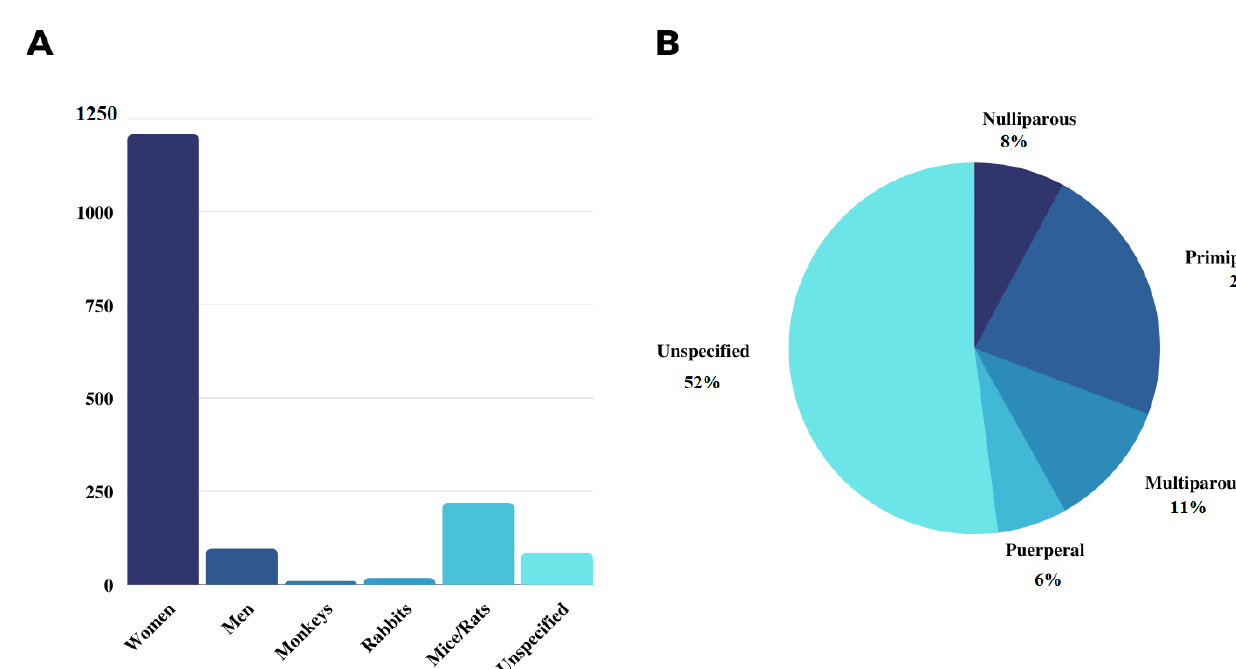
Figure 2. Studied populations ( A ) and female classification ( B ) found in the analyzed studies. Considering the electrical intensity and the intervention site, we found that 16 studies (69.6% of the total reviewed bibliography) treated the studied population with electric intensities varying from 20–50 Hz. Additionally, no differences were observed regarding the electrical intensities applied to humans compared to animals, except for the study by [5], which used the intensity of 1 Hz in Rhesus monkeys, aiming to evoke an answer in the lower urinary tract. Regarding the most approached regions to perform electrical stimulation, 14 studies reported a direct approach to the anogenital region (vagina, penis and anus), while other 9 studies carried out the induction in nerves, i.e., pudendal, tibial, bulbospongiosus, and pubococcygeus nerves. The relation between the site and intensity of the application performed by each study are reported in Table 3. Table 3. Relation between electric current and site of intervention reported by the reviewed studies. No.